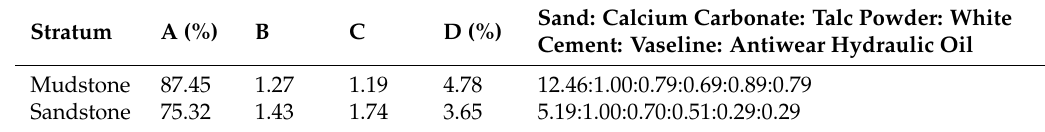
Table 7. The optimal ratio of similar-material in aquifuge Sand: Calcium Carbonate: Talc Powder: White Cement: Vaseline: Antiwear Hydraulic Oil